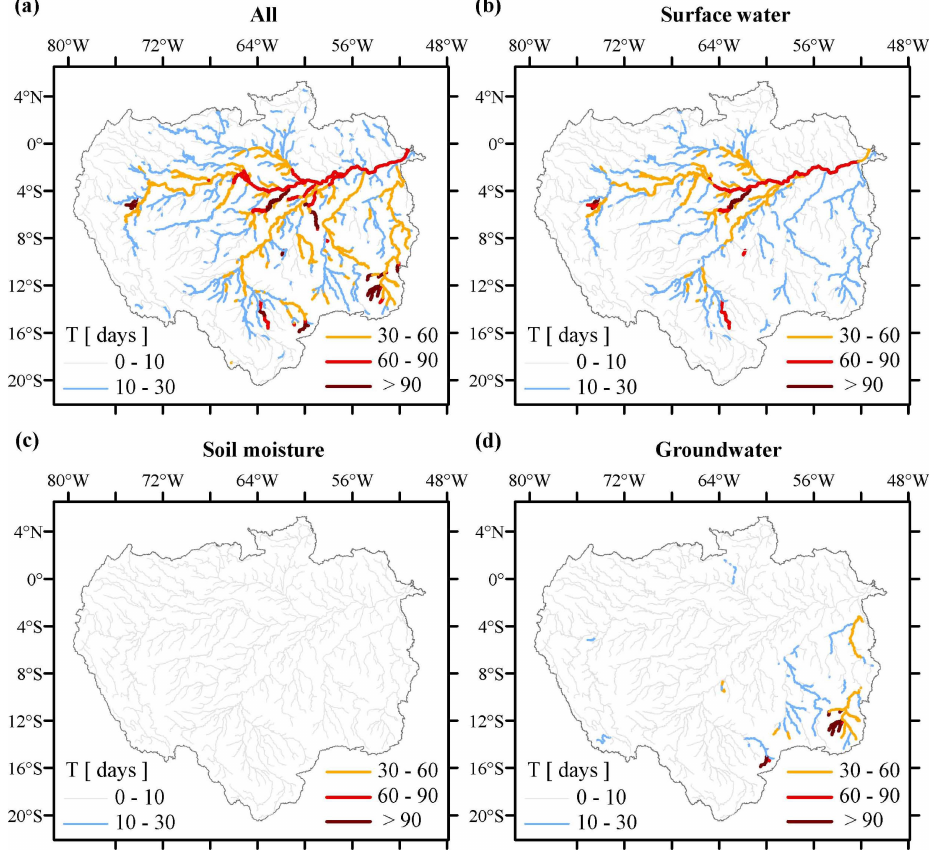
Fig. 4. Spatial distribution of T values considering (a) all, (b) surface water, (c) soil moisture and (d) groundwater model states variables. Results are shown only in rivers reaches with upstream drainage area larger than 3000km 2